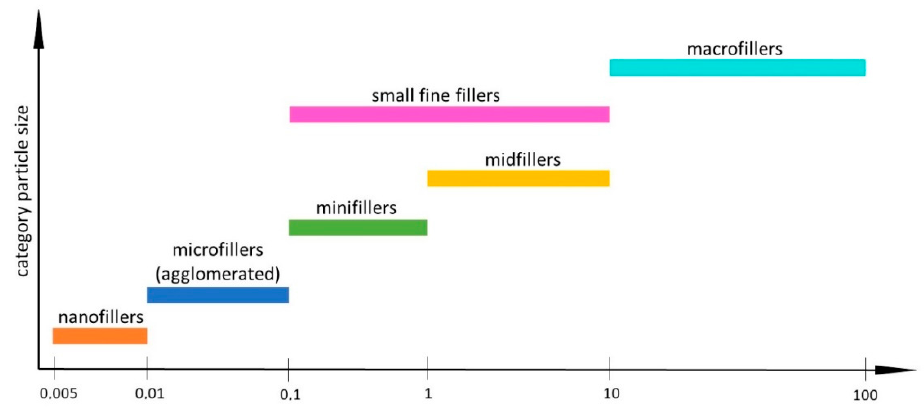
Figure 2. Filler size categories by Bayne and Heymann.